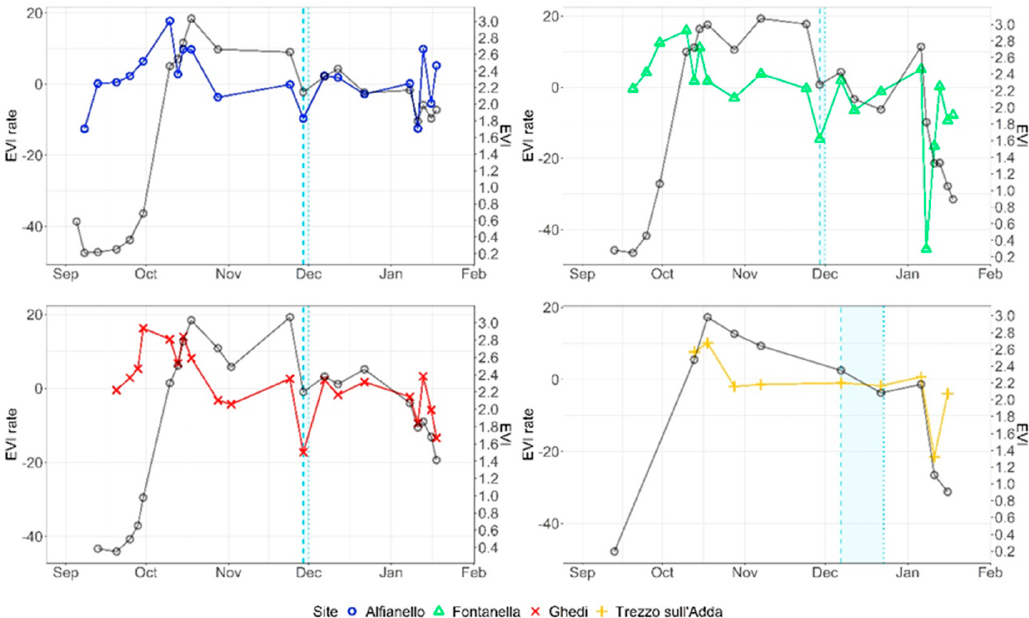
Figure 6. Trends of EVI (Enhanced Vegetation Index) of a white mustard cover crop and of its rate of variation in the four monitoring sites. The rate of variation is reported with colored lines, while EVI is in black. The starting date of the first frost event estimated with the ‘rate of decrease’ method based on EVI is a vertical light-blue dashed line, while the ending date is a vertical light-blue dotted line.